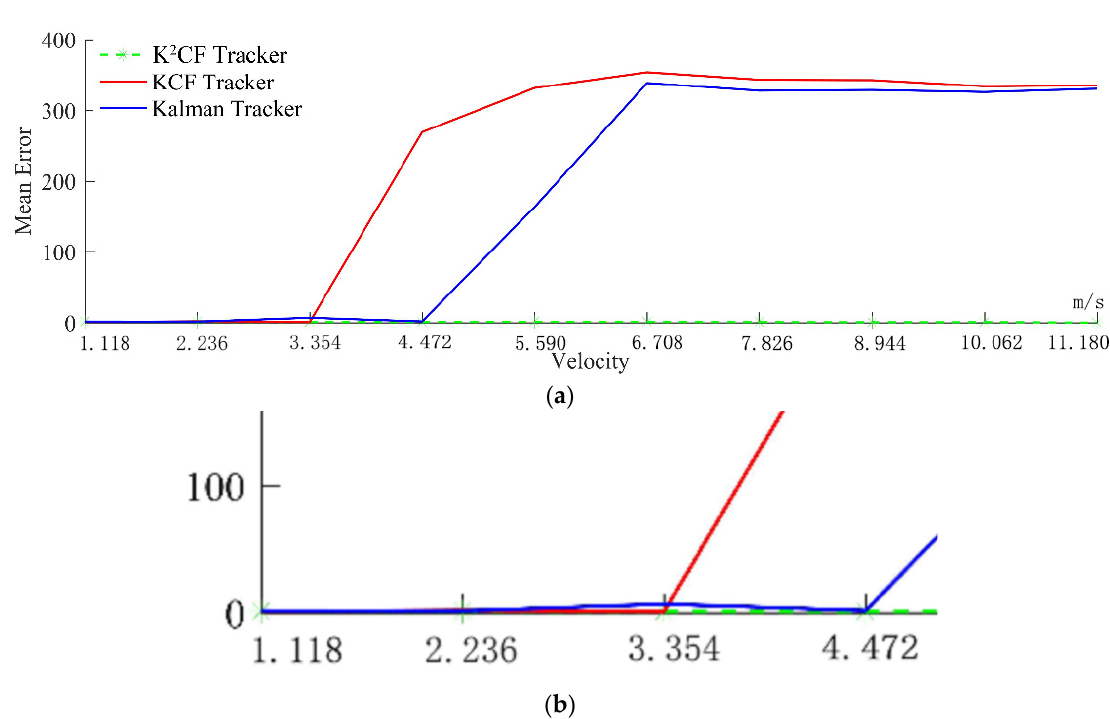
Figure 14. Detectable velocity of uniform state: ( a ) the mean error of velocity from 1.118 m/s to 11.180 m/s; ( b ) amplification of velocity error from 1.118 m/s to 4.472 m/s.